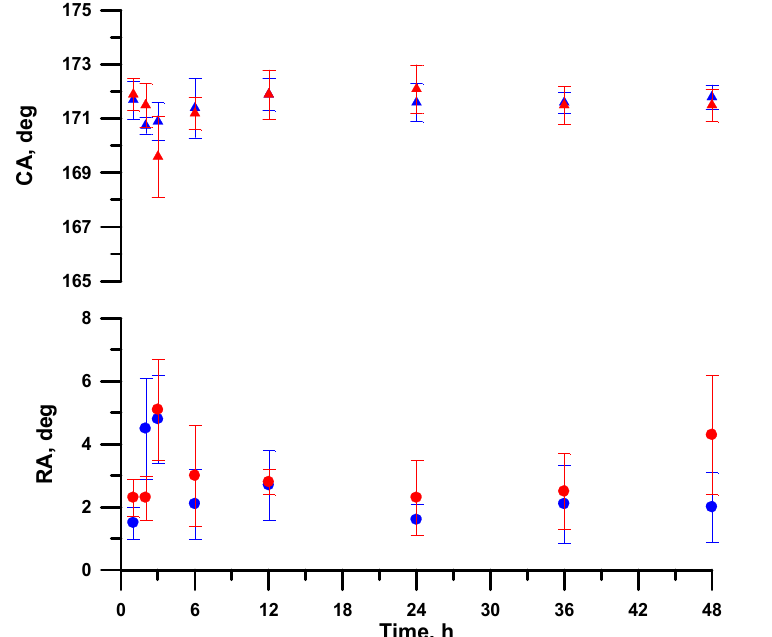
Figure 2. The contact (triangles) and roll-off (circles) angles for the superhydrophobic samples before (blue symbols) and after (red symbols) different durations of immersion in the dispersion of K. pneumoniae . A separate freshly prepared sample was used for each immersion duration; that is why the initial values (blue symbols) show some variation.